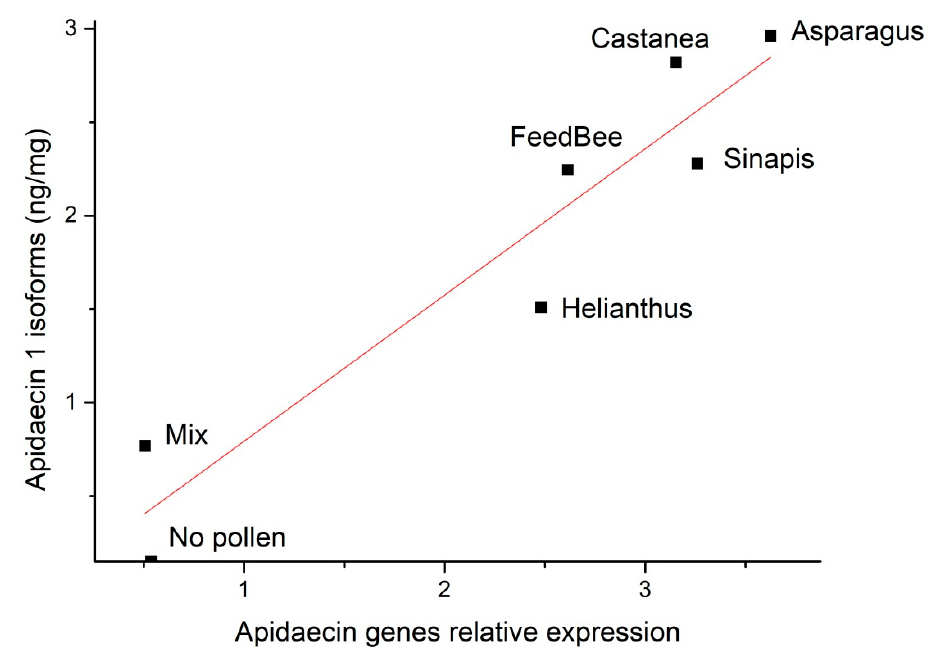
Figure 3. Correlation of apidaecin genes relative expression and apidaecin1 isoforms levels in bee groups that were fed different types of diet. Individual points represent median values of each group.